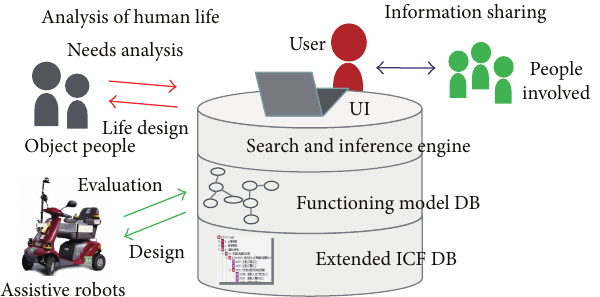
Figure 11: Life design support tool based on an extended ICF database